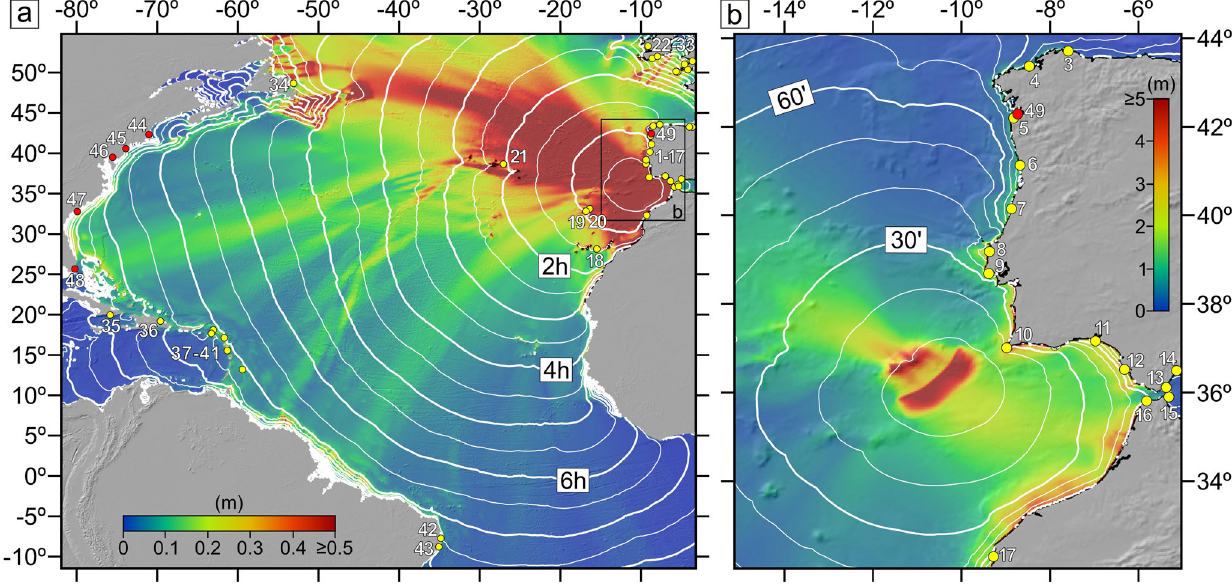
Fig. 4 The HAT tsunami simulation. a Tsunami simulation for the Horseshoe Abyssal plain Thrust (HAT) over a regional bathymetric map showing maximum wave heights and tsunami travel time (30 min intervals), and illustrating the effects of bathymetric roughness in tsunami energy propagation. b Close-up of the HAT tsunami simulation showing maximum wave heights and tsunami travel times (10 min intervals) highlighting the most affected areas along the SW Iberian and NW Moroccan margins. White numbers refer to localities listed (Id) in Supplementary Tables 2 and 3. Yellow circles label locations of run-up and time arrival reports in Supplementary Tables 2 and 3. Red circles indicate locations with no historical